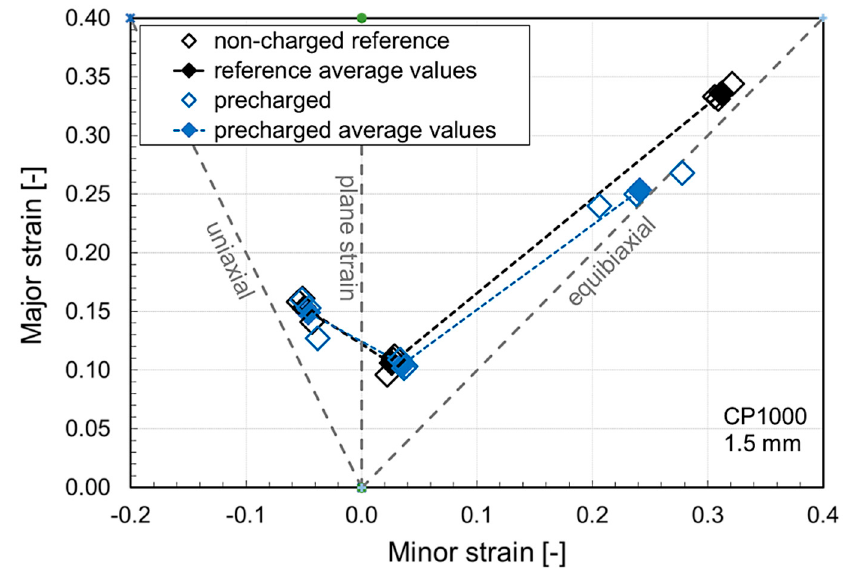
Figure 9. Forming limit curves (FLC) of reference and hydrogen ‐ charged Nakajima specimens.